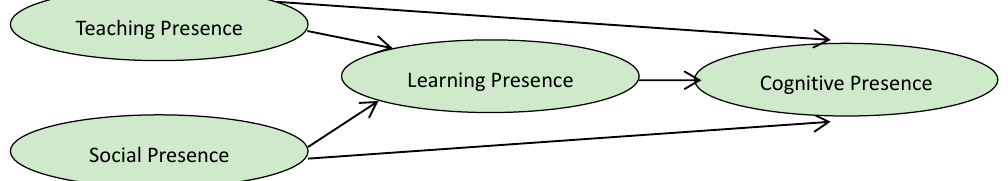
Figure 2. Hypothesized model of the four